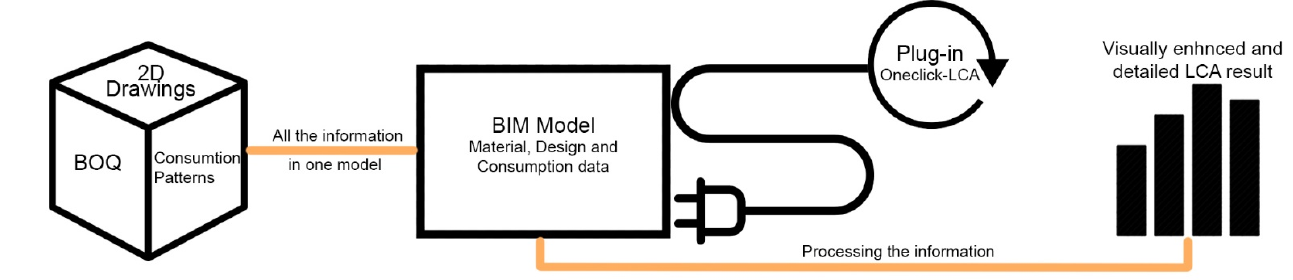
Figure 1. Workflow and process of estimation of embodied carbon.